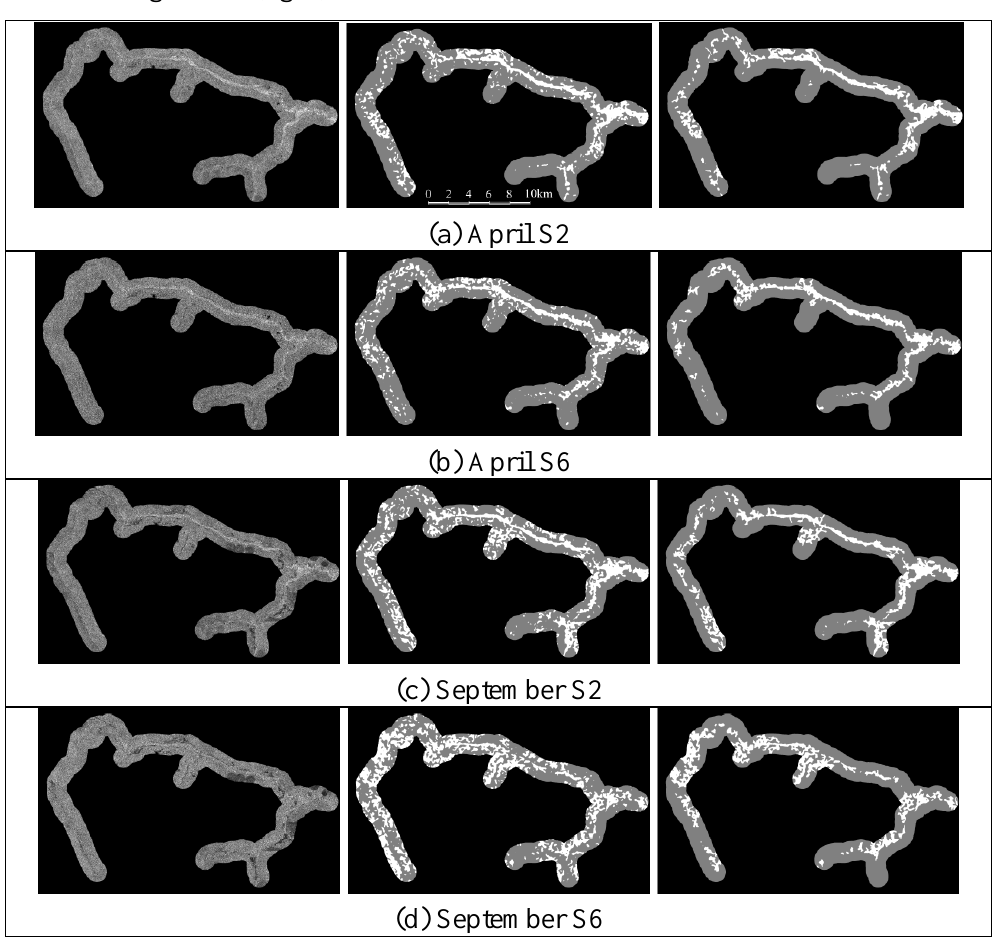
Figure 5. SAR images (left), classification results obtained with the MAMSEG algorithm for the two periods and the two incidence angles using 80 iterations (center) and classification results after they have been “cleaned” using the stream network and the contamination algorithm